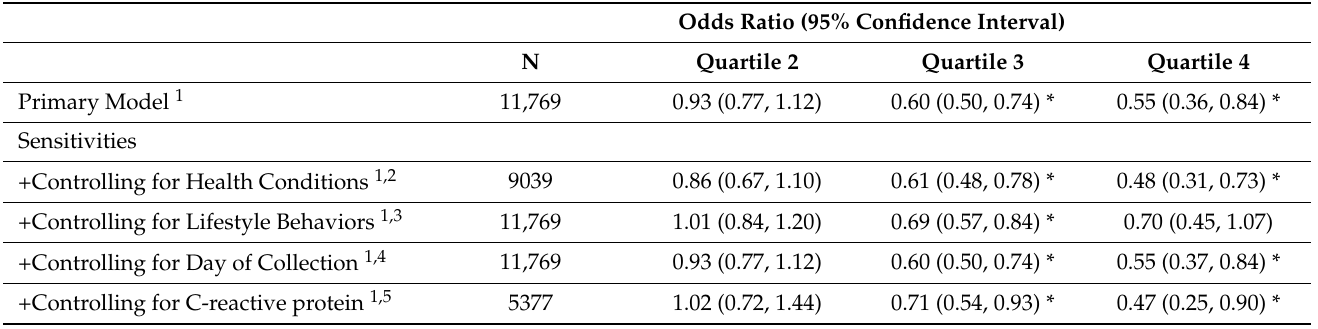
Table 3. Association between Alternate Mediterranean Diet score (aMED) and moderate to severe depressive symptoms, NHANES